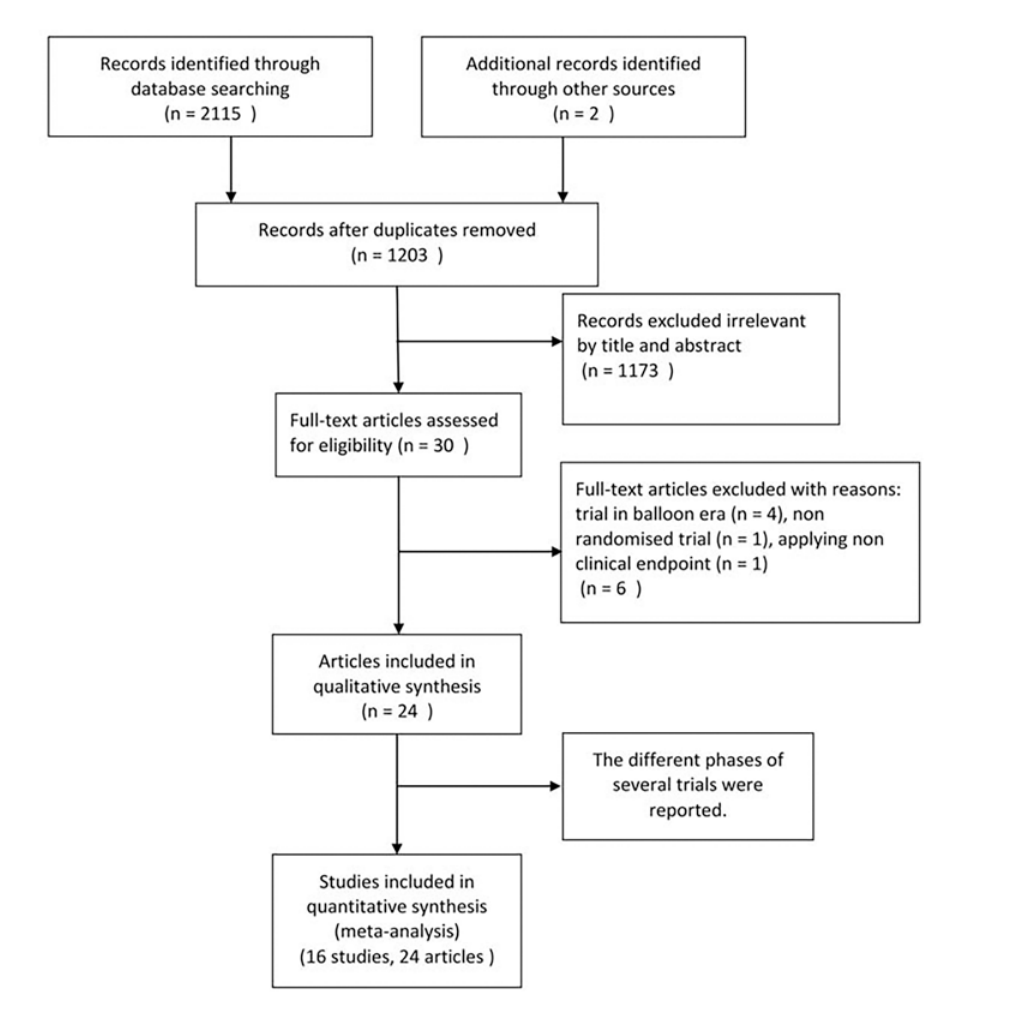
Fig 1. The flow chart of literature inclusion. (Flow